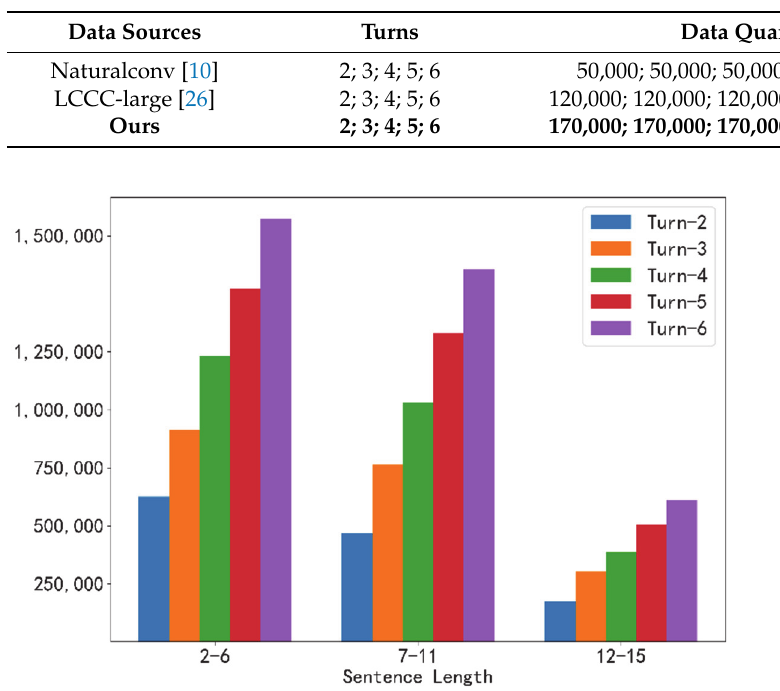
Figure 5. Sentence length distribution of the data sets.